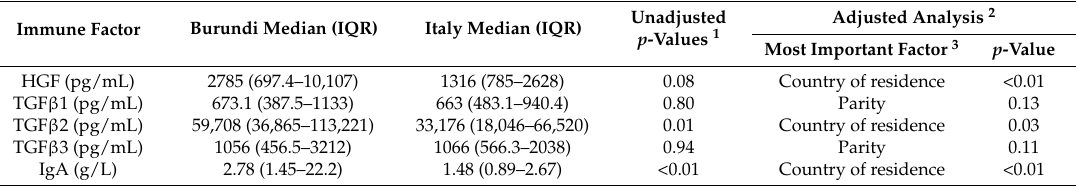
Table 2. Univariate and adjusted analysis for comparison of growth factors and IgA levels in the colostrum of women from Burundi and Italy.